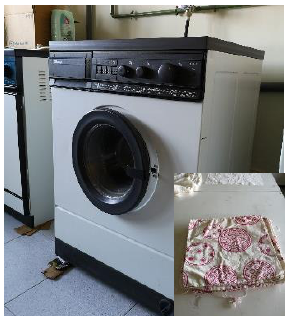
Figure 3. Image of the experimental Balay T5609 washing machine and the support fabric for washing cycles (inset).